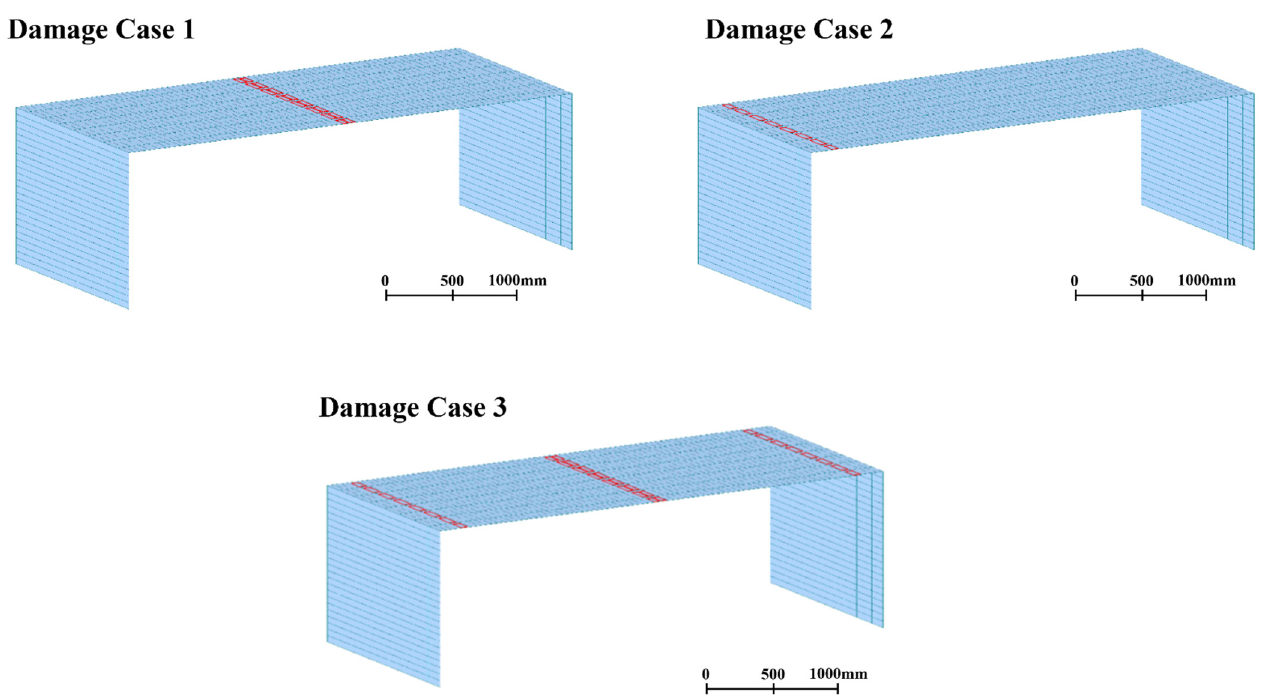
Figure 4. Damage locations of damage cases for rigid-frame-bridge modeling.